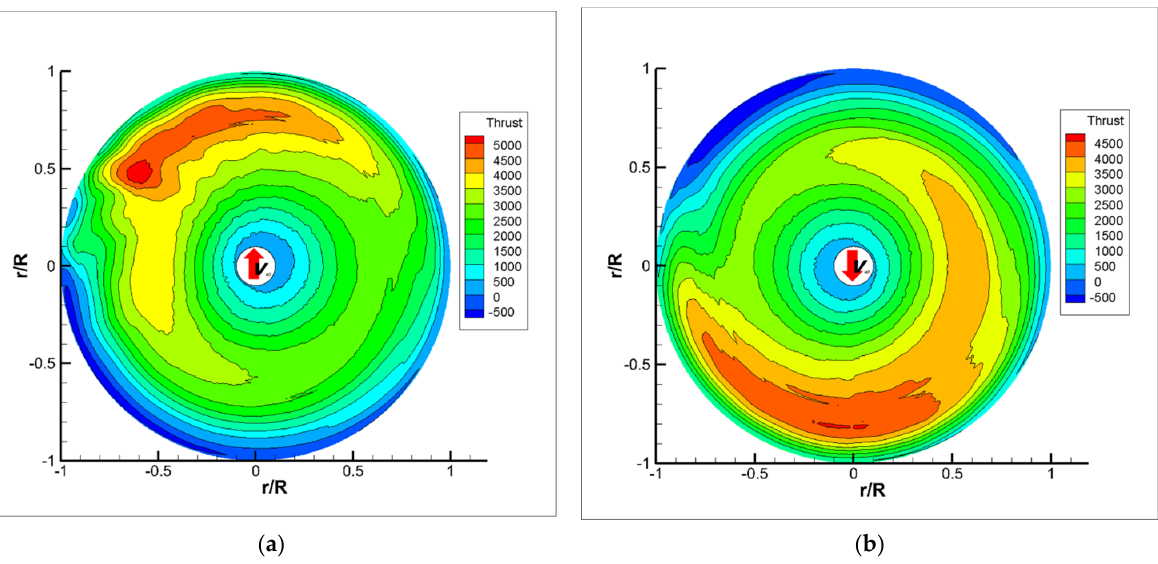
Figure 16. Thrust distribution of the rotor in different states at 1R height: ( a ) τ = − 5°; ( b ) τ = +5°.